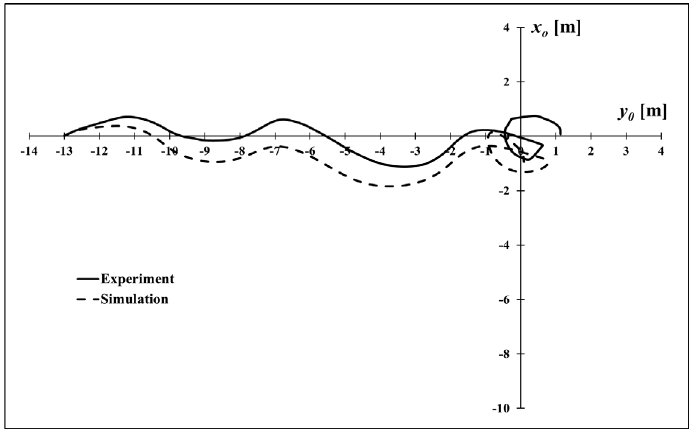
Figure 17. Comparison of experiment and simulation when the initial heading angle is 0 degrees.